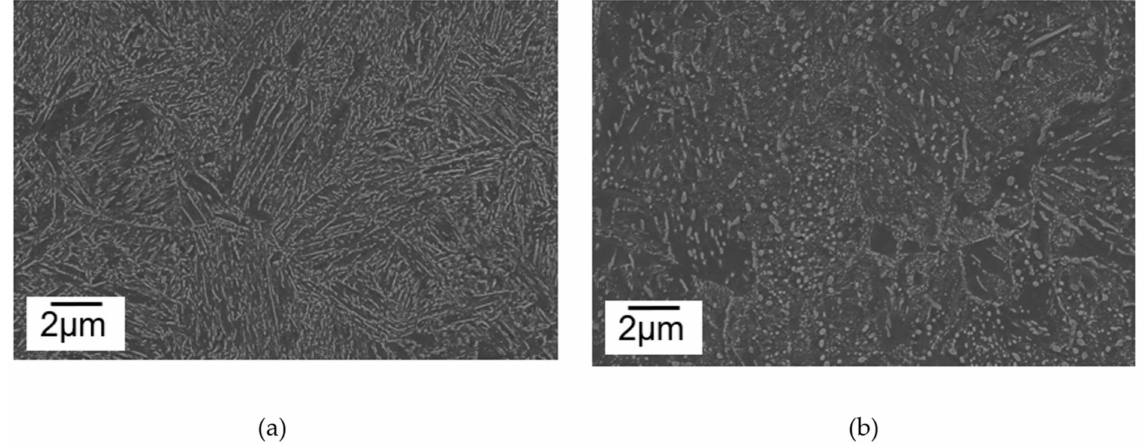
Figure 2. SEM micrographs of the tempered microstructure of 50CrMo4 austenitized at 860 ◦ C, quenched in oil, and tempered at ( a ) 200 ◦ C leading to 57HRC, and ( b ) 550 ◦ C leading to